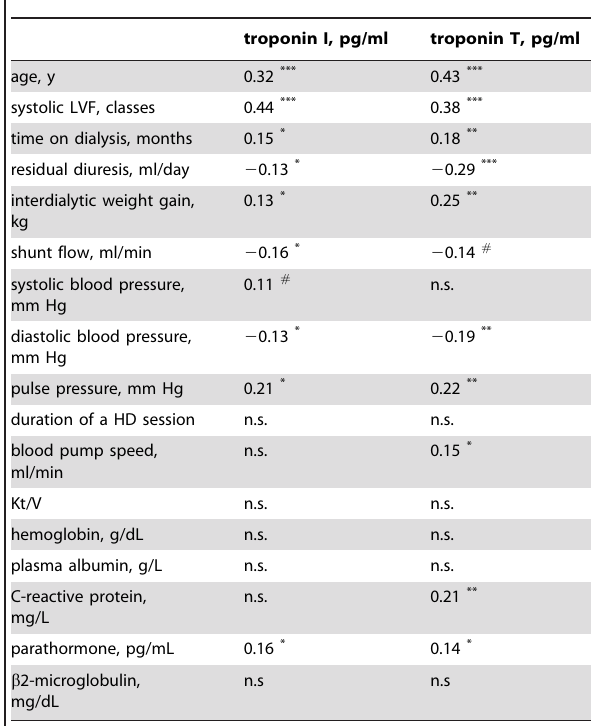
Table 2. Univariate correlations (Pearson’s r) of the plasma troponin concentration with general and dialysis-specific parameters